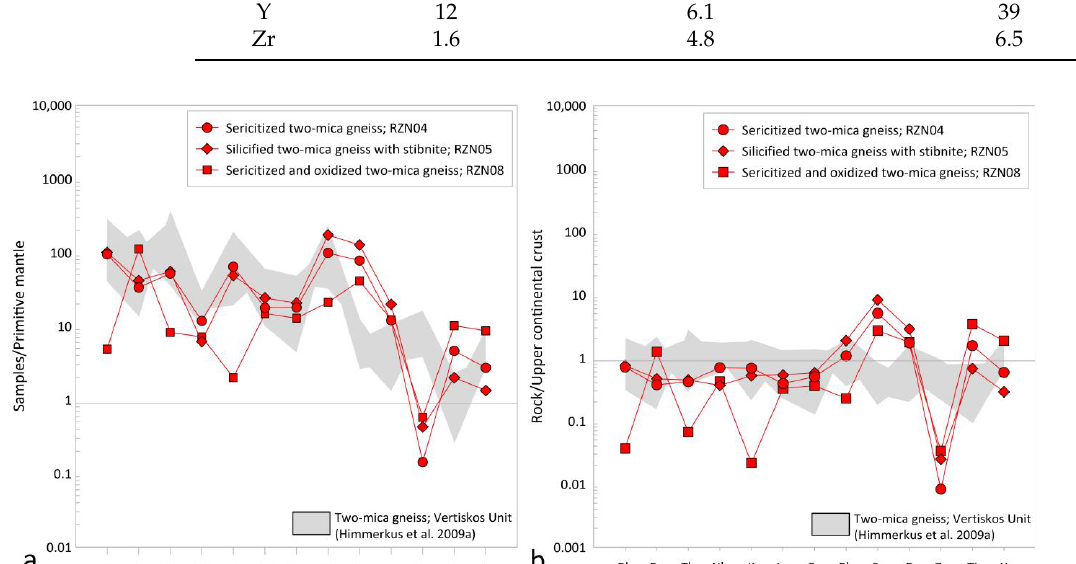
Figure 11. Primitive mantle ( a ) and upper continental crust ( b ) normalized logarithmic spider dia- grams of three sericitized and/or silicified two-mica gneiss analyzed in the present study and the plot areas (gray shaded) of the reference two-mica gneiss from the Vertiskos Unit sourced by [36] (primitive mantle and upper continental crust normalized values after [52] and after [53], respec- tively).